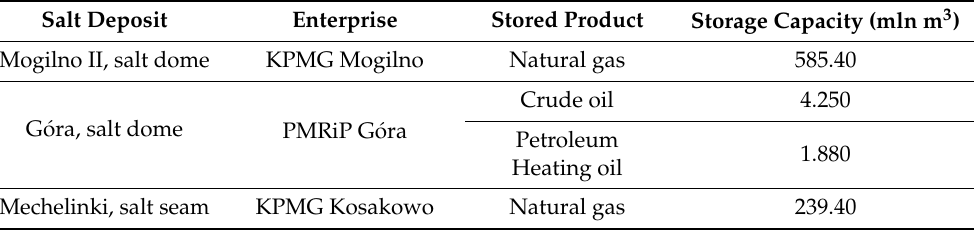
Table 2. Underground storages in salt caverns,